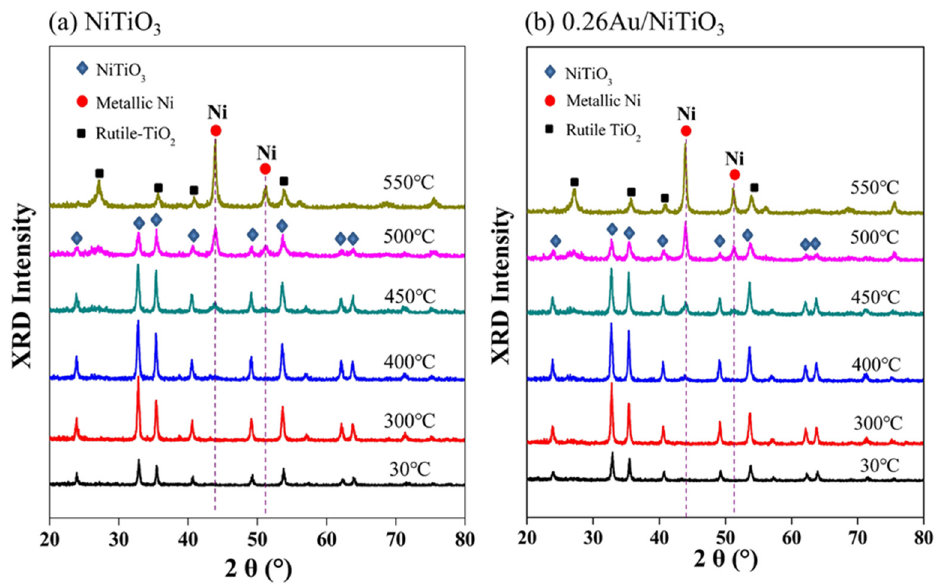
Figure 5. In situ XRD patterns of the NiTiO 3 ( a ) and 0.26 Au/NiTiO 3 ( b ) taken at different tempera- tures in H 2 atmosphere.